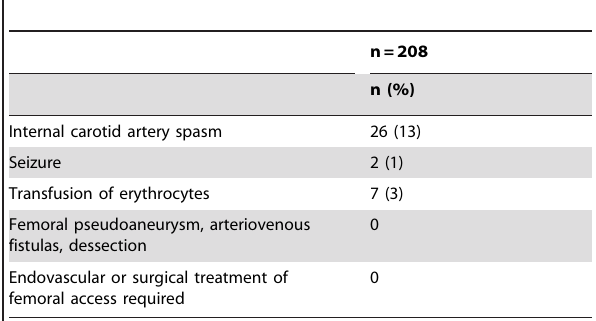
Table 3. Periprocedural Findings and